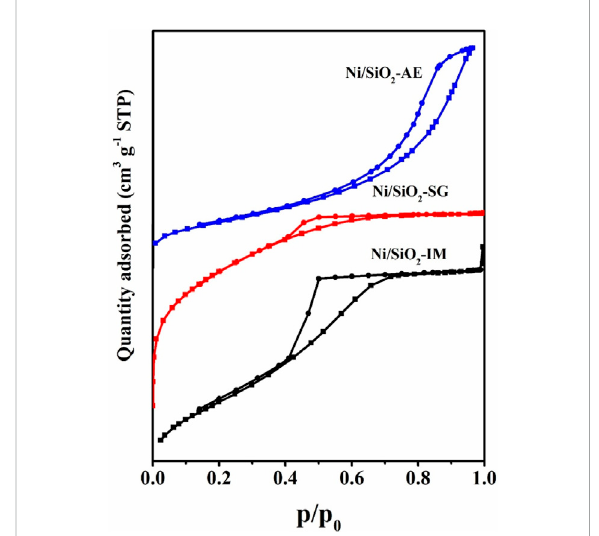
FIGURE 1 N 2 adsorption-desorption isotherms of Ni/SiO 2 catalysts.